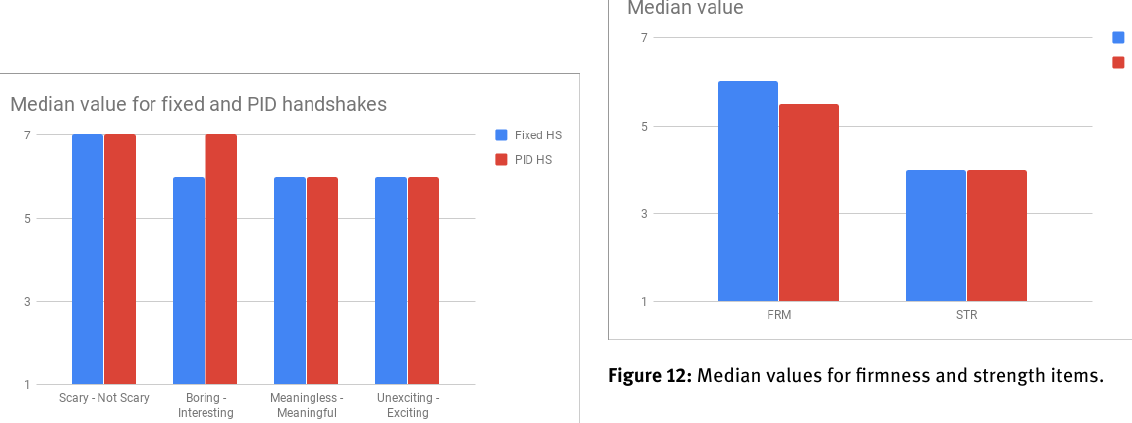
Figure 9: Mean values for interaction items.